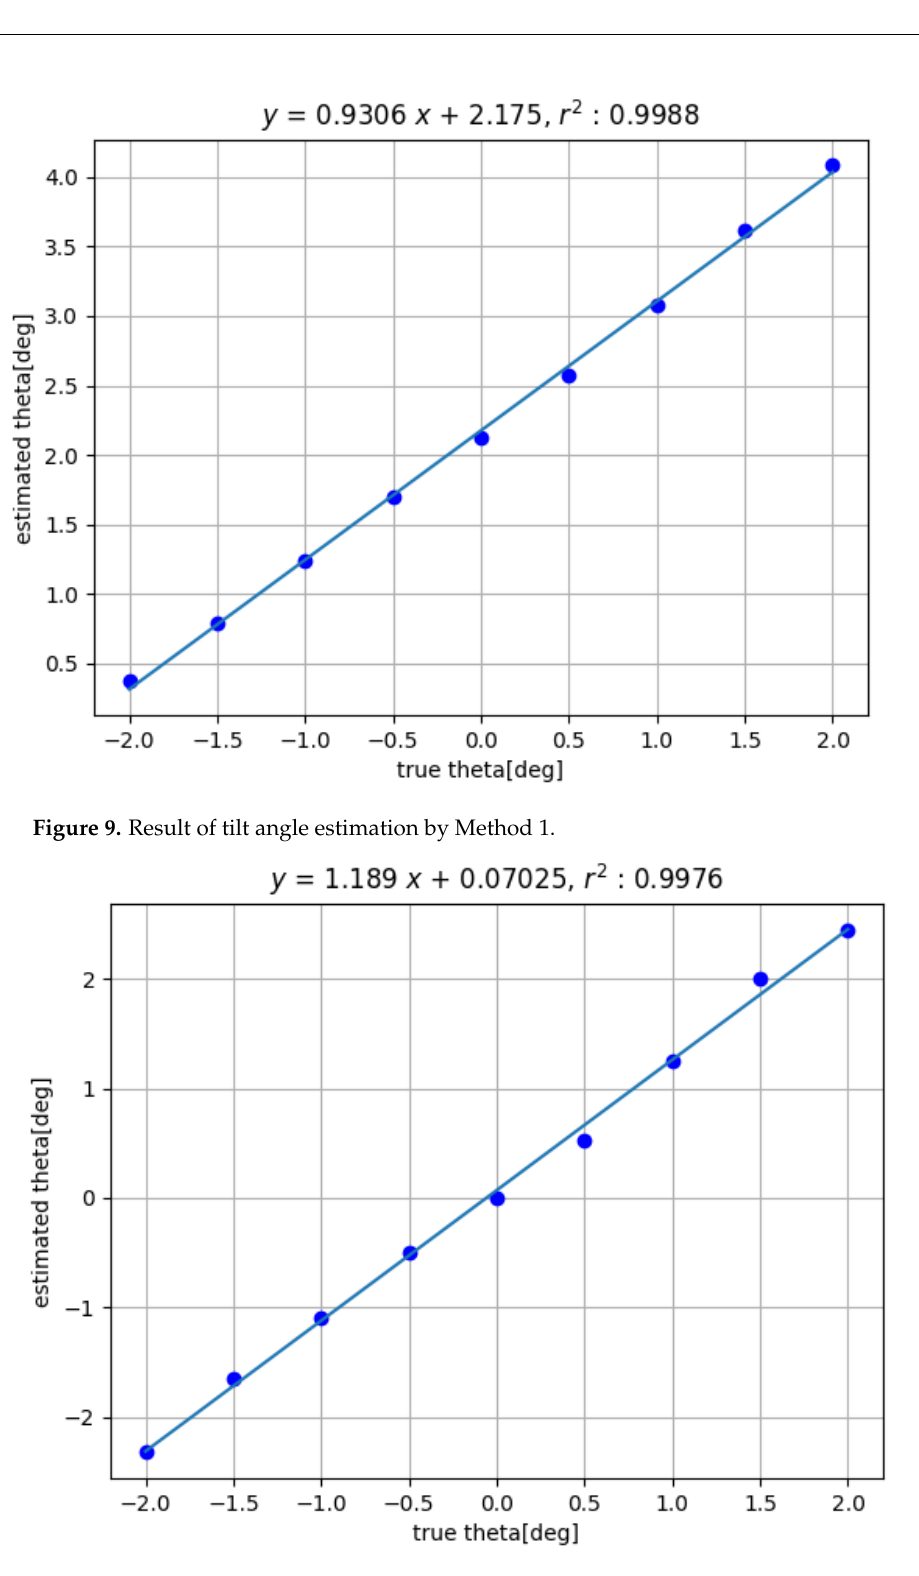
Figure 10. Result of tilt angle estimation by Method